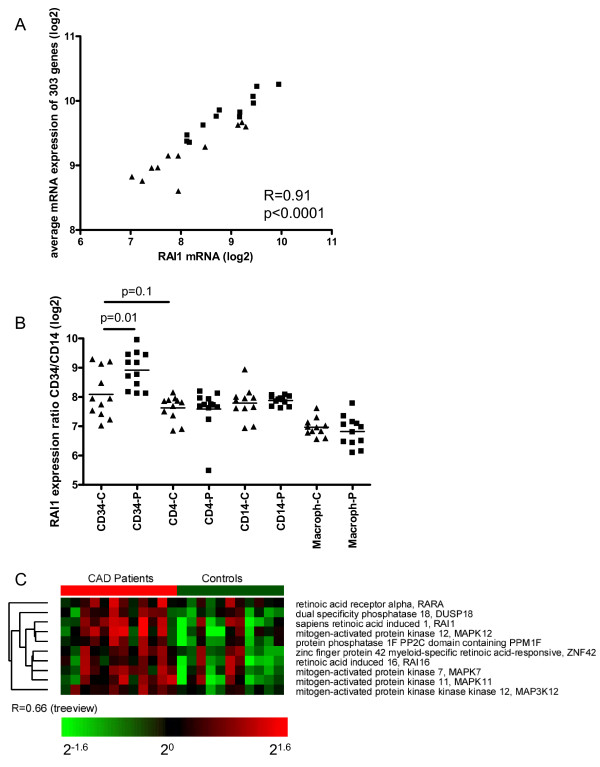
A retinoic acid-induced signature in CD34+ cells from CAD patients. A. The induced signature in CD34+ cells from CAD patients correlates with the expression of RAI1. The average expression of the 303 genes of the induced signature of CAD patients is plotted against the expression of RAI1 (CAD patients are represented by squares, controls by triangles). B. Retinoic acid-induced 1 gene expression in different cell types in CAD patients and controls. C. The expression of RAI1 is shown for all studied cell types in CAD patients (squares) and controls (triangles).